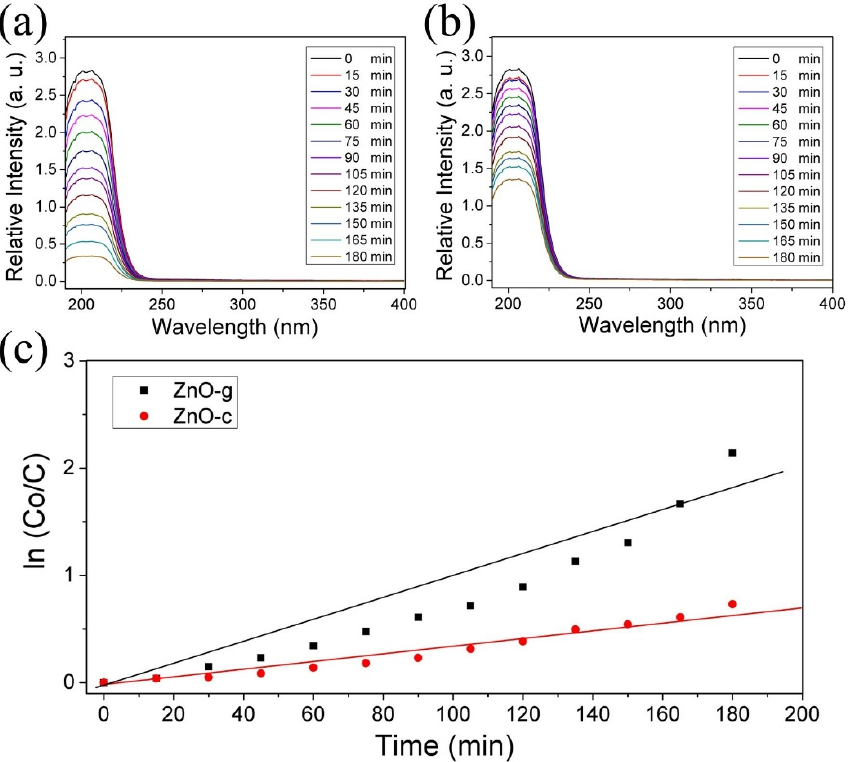
Figure 7. Absorbance spectra of Na 2 CO 3 dissolution over time of interaction with ( a ) ZnO grass ‐ like (ZnO ‐ g) and ( b ) ZnO cane ‐ like (ZnO ‐ c) structures. ( c ) The comparison of kinetics in CO 2 adsorption between ZnO ‐ g and ZnO ‐ c.